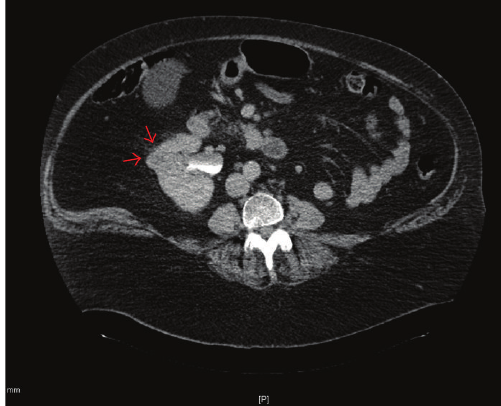
Figure 2: Nonenhancing hypodense mass in the anterolateral cortex of right kidney and absence of left kidney from previous nephrectomy.